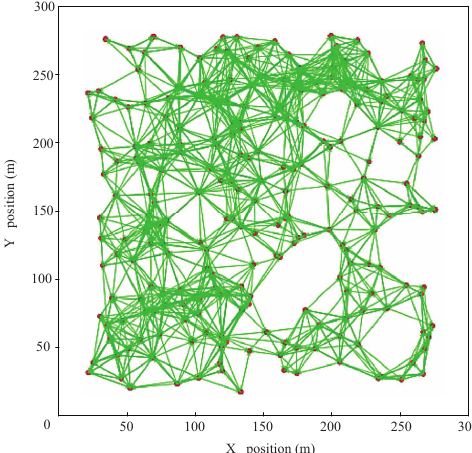
Figure 10. The random network topology on NS-3 simulation platform.